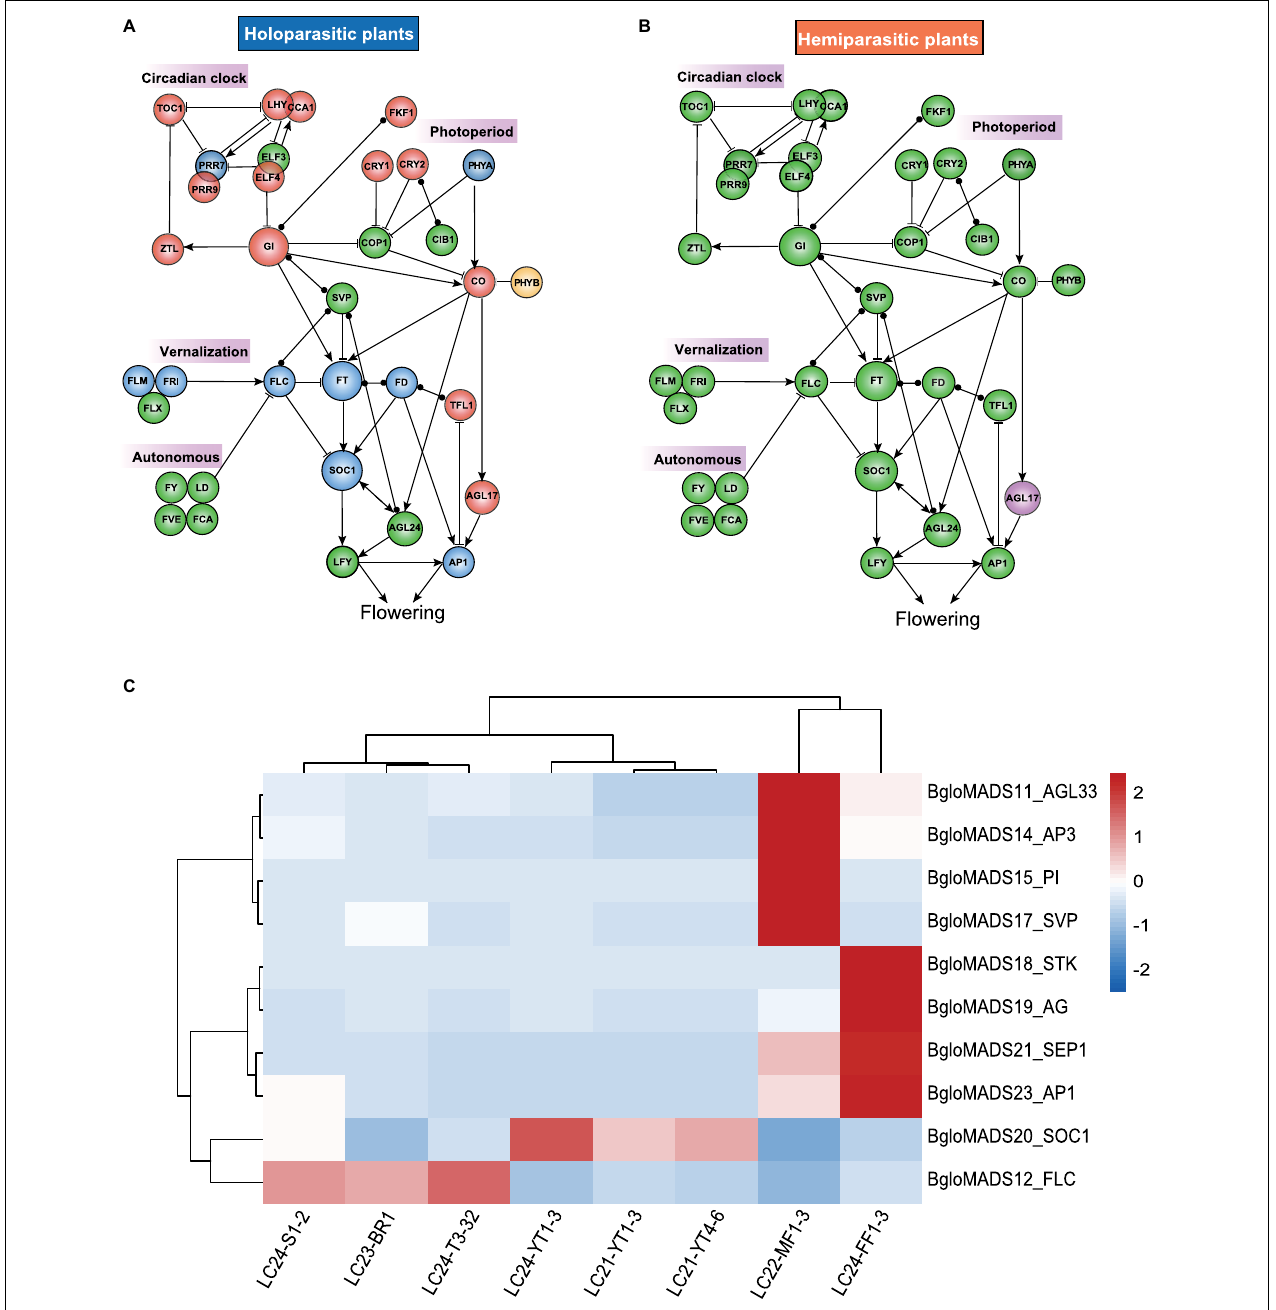
FIGURE 5 | Four simplified pathways controlling flowering in parasitic plants and expression profiles of MADS-box genes for Balanophora (Photoperiod, Circadian clock, Autonomous, Vernalization Pathways). Panels (A,B) represent holoparasitic plants B. subcupularis , B. fungosa var. globosa , Sapria and hemiparasitic plants S. parasitica , S. album , M. oleifera , respectively. Red circles represent all lost in holoparasities. Green circles represent all retained in hemiparasites. Yellow represents only lost in Balanophora . Blue represents the loss in Sapria . Purple represents the loss in S. parasitica . The arrow indicates promoting gene activation, the blunt line indicates gene inhibition, and the two endpoints indicate no interaction in known directions. Genes FT , LFY , and SOC1 integrate signals from multiple pathways. And in the pathways, SVP , FLC , SOC1 , AGL24 , AGL17 , and AP1 belong to MADS-box gene family, while the rest genes correspond to non-MADS-box genes. (C) The red and blue colors indicate the expression levels of BgloMADS genes from high to low, and white indicates the median expression level in the heatmap. The tissues cover three stages, stage 1: samples containing different tuber sizes, LC21-YT1-3 ( < 8 mm, duplicate: LC21-YT1, LC21-YT2, and LC21-YT3), LC21-YT4-6 (8 ∼ 15 mm, duplicate: LC21-YT4, LC21-YT5, and LC21-YT6), stage 2 samples without visible inflorescence tissues, tuber and host root were collected and named as LC24-YT1-3 (duplicate: LC24-YT1, LC24-YT2, and LC24-YT3), stage 3 samples with inflorescence were separated into different tissues, including tuber LC24-T3-32 (duplicate: LC24-T3 and LC24-T32), male inflorescence LC22-MF1-3 (duplicate: LC22-MF1, LC22-MF2, LC22-MF3), female inflorescence LC24-FF1-3 (LC24-FF1, LC24-FF2, LC24-FF3), inflorescence stem LC24-S1-2 (duplicate: LC24-S1, LC24-S2), and bracts (LC23-BR1).